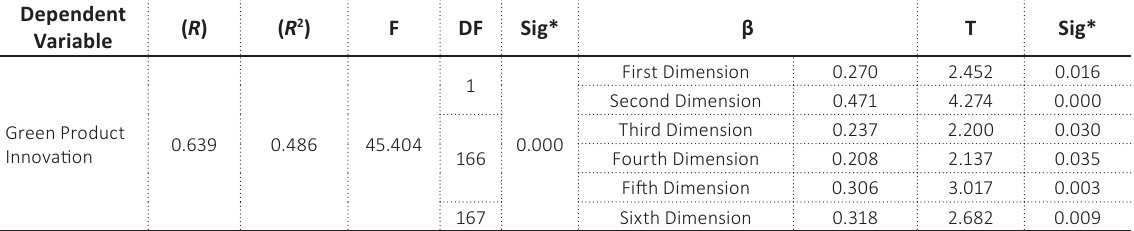
Table 2. Multiple regression analysis to guarantee the impact of GOI on green product innovation Dependent